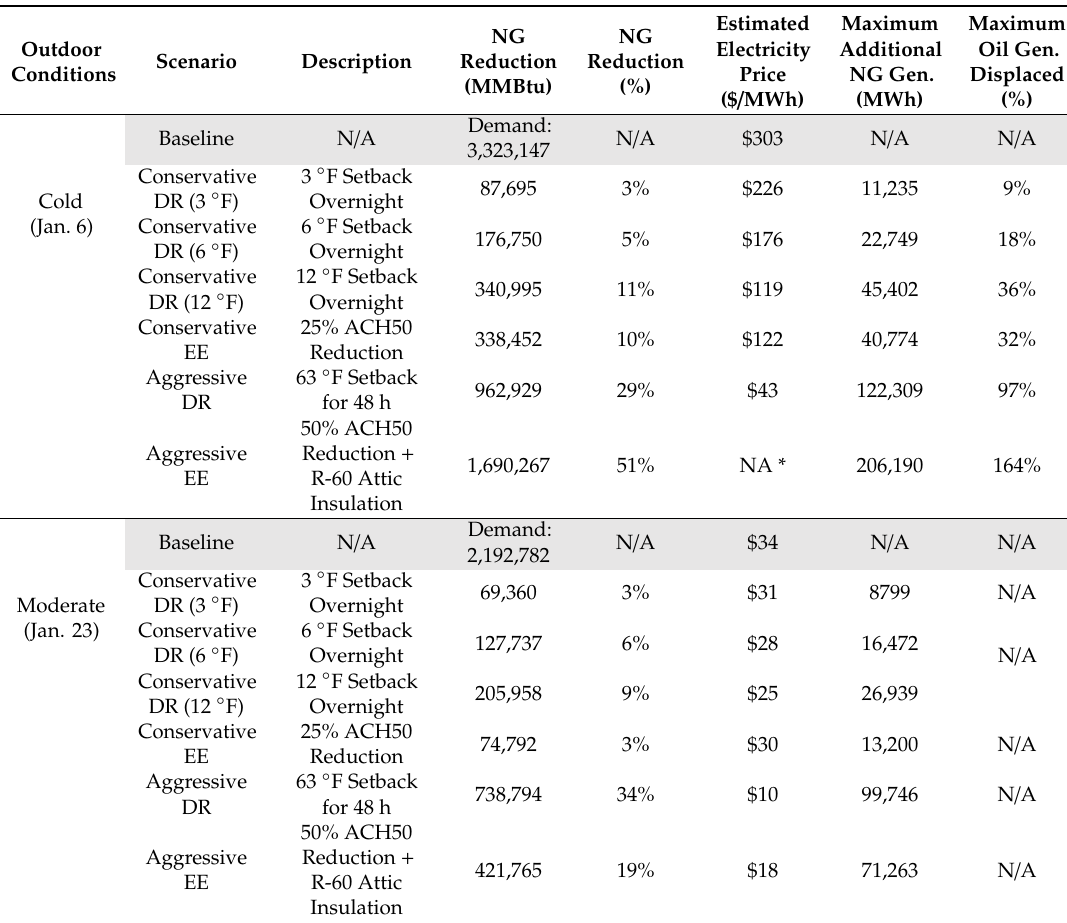
Table 2. Demand response (DR) and energy e ffi ciency (EE) reductions in natural gas demand and estimated impacts on natural gas price, maximum potential additional electricity generation by natural gas, and maximum potential oil generation displaced for the cold weather event on 6 January 2018. The heat rate of a natural gas combined cycle plant is used to convert natural gas savings into additional possible electricity generation. Baseline demand is total volume served to LDCs on indicated date from both Algonquin and Tennessee Zone 6